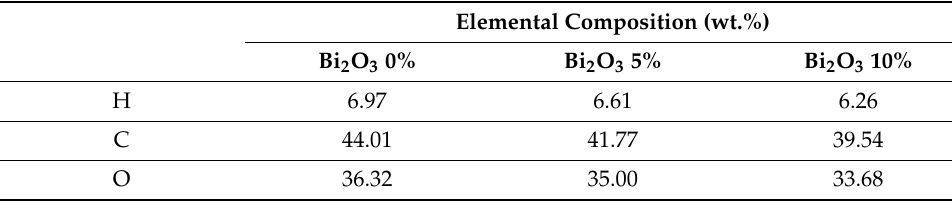
Table 1. Elemental composition and density of the synthesized